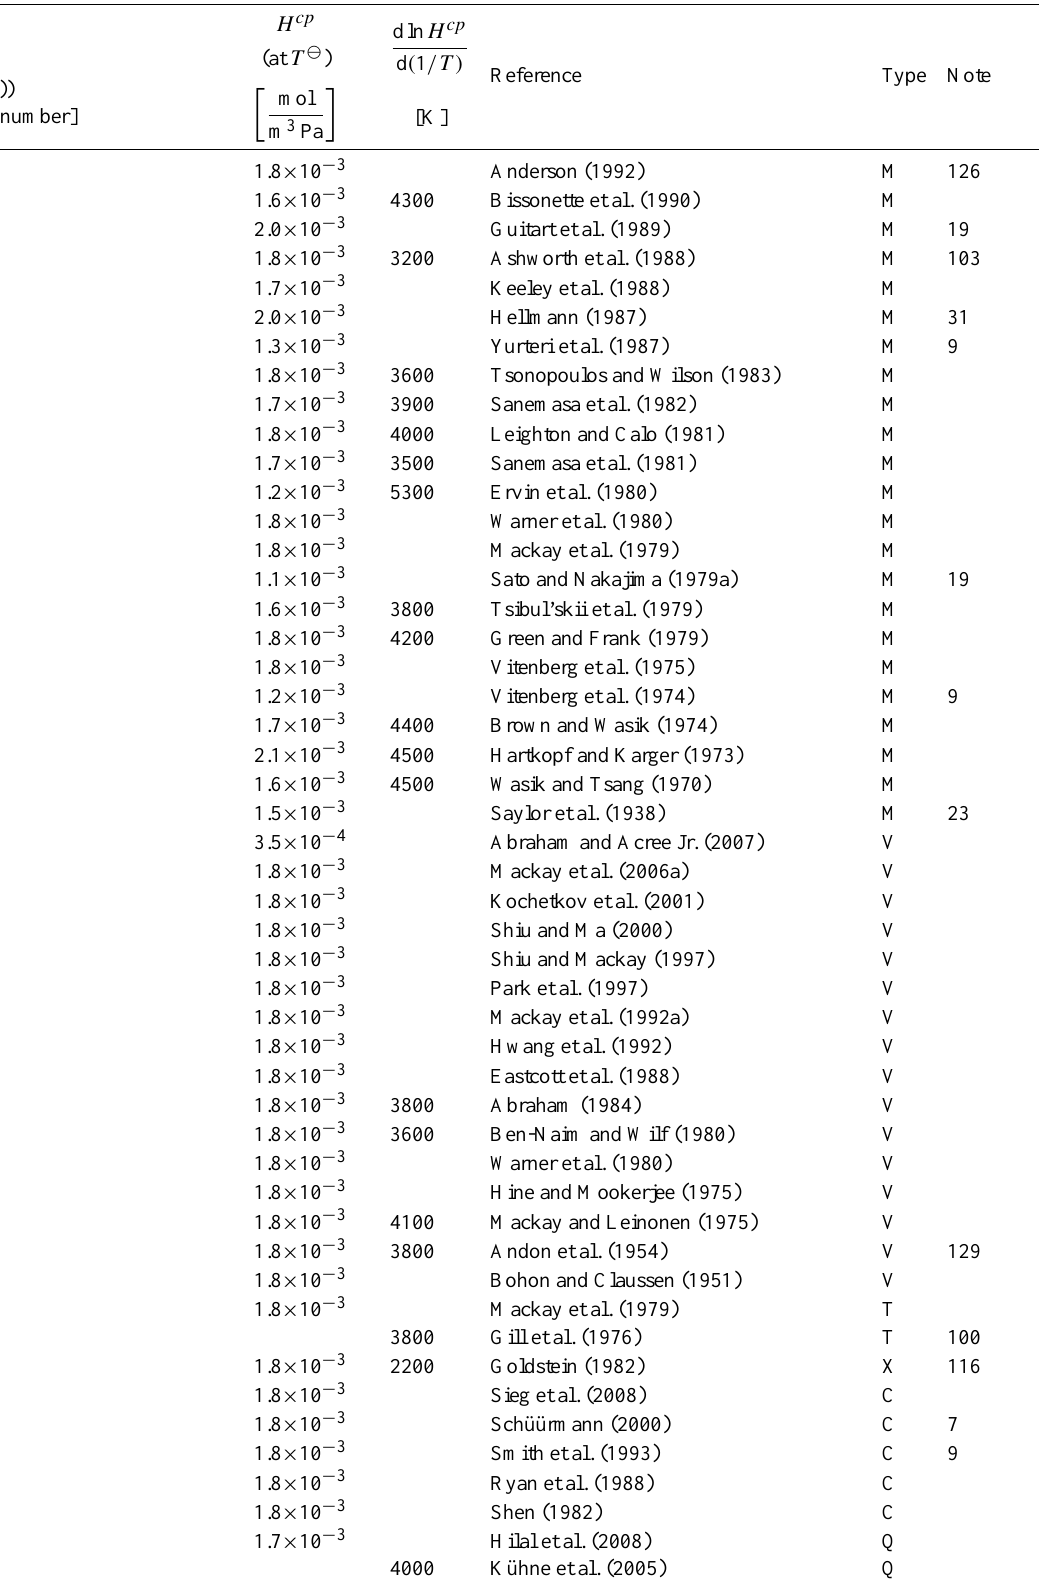
Table 6: Henry’s law constants for water as solvent (...continued)